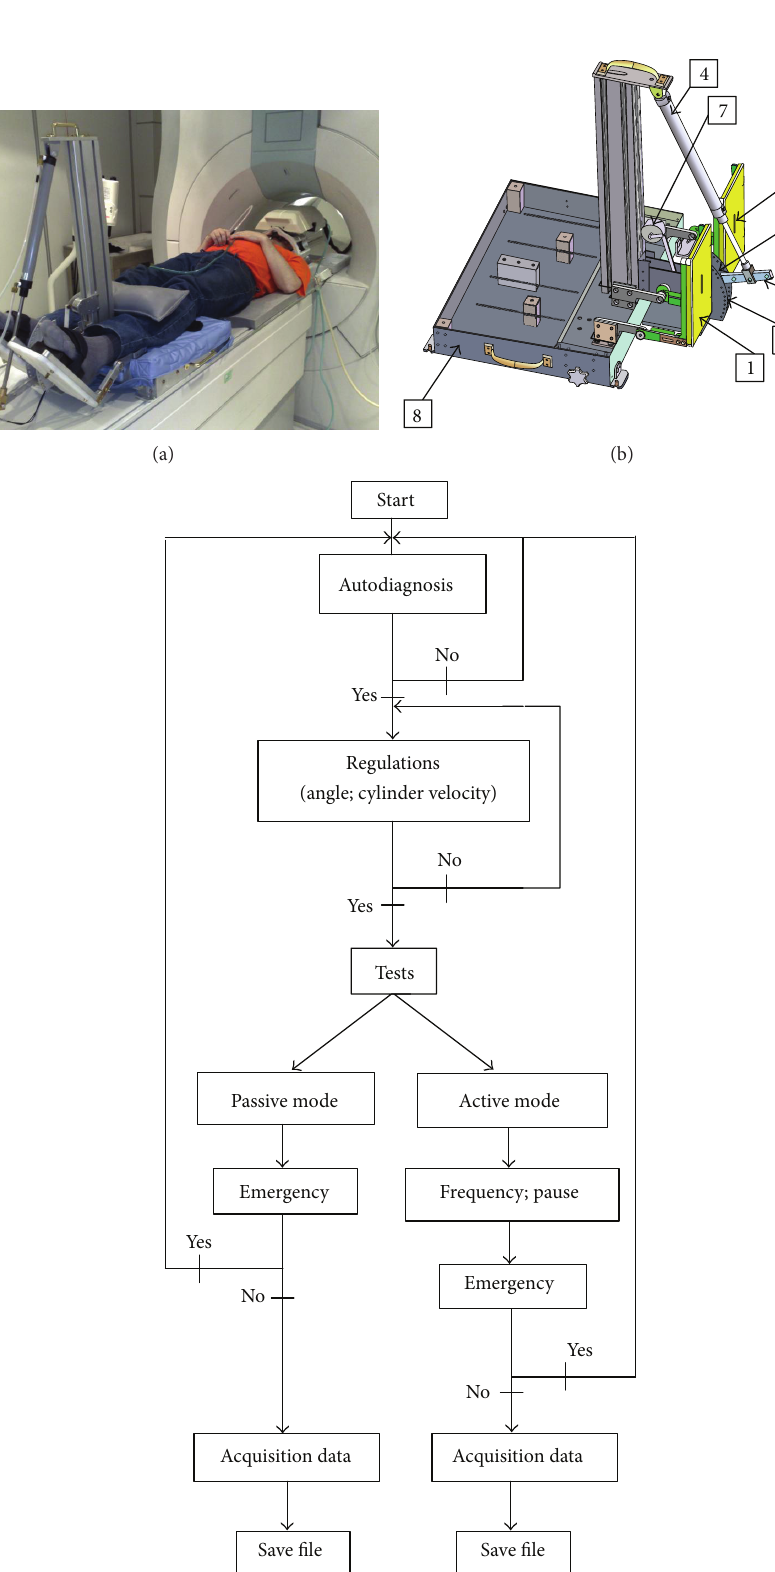
Figure 1: (a) Bra.Di.P.O. in the magnetic resonance chamber during test. (b) Bra.Di.P.O. first prototype. (c) Bra.Di.P.O. flow